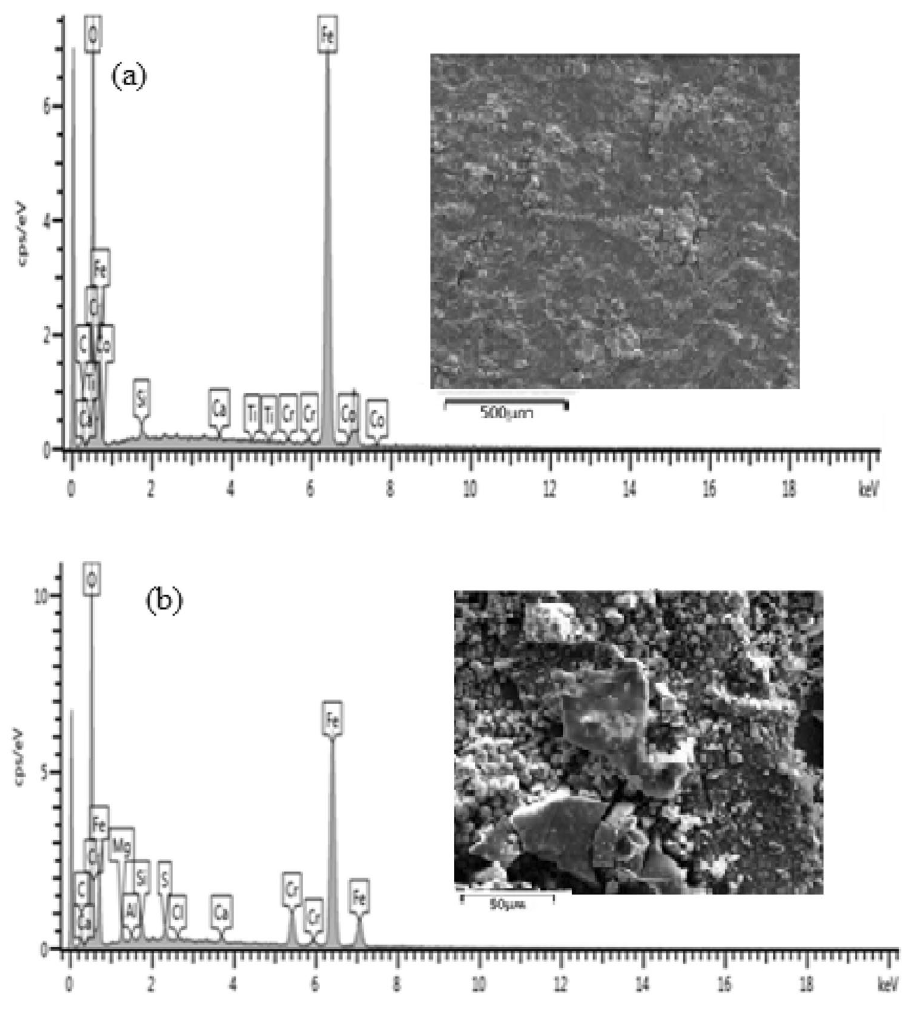
Figure 9. Energy diffraction spectron (EDS) of annealed sample: ( a ) before corrosion and ( b ) after corrosion.